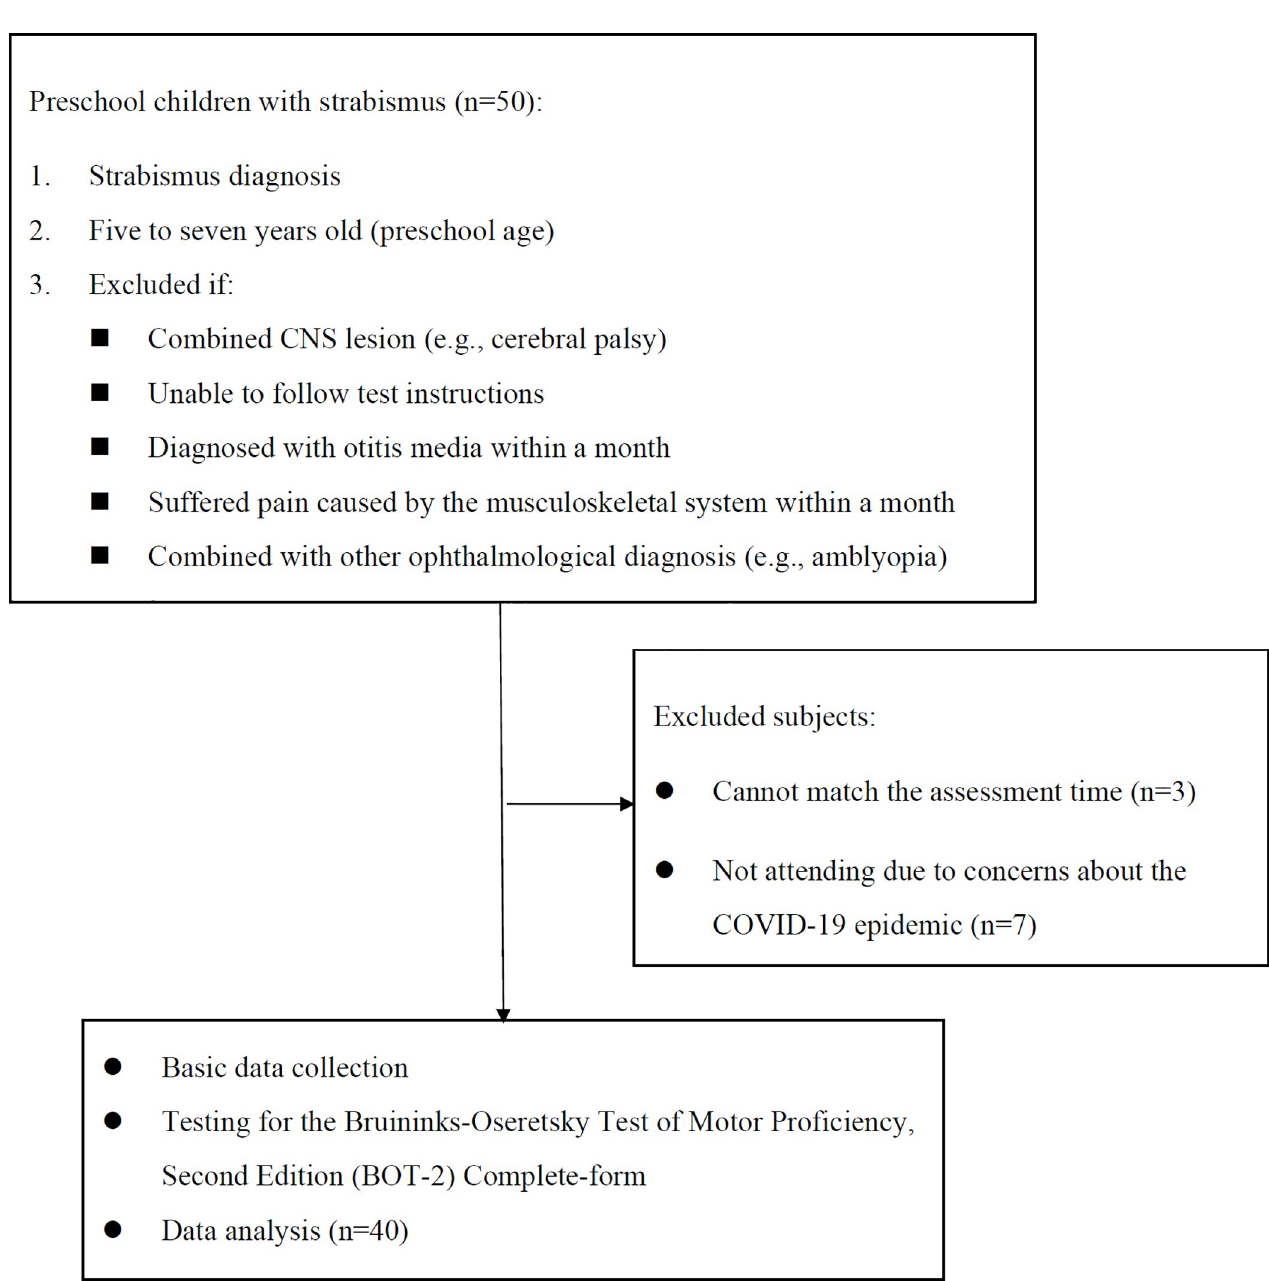
Fig 1. Flowchart for inclusion of